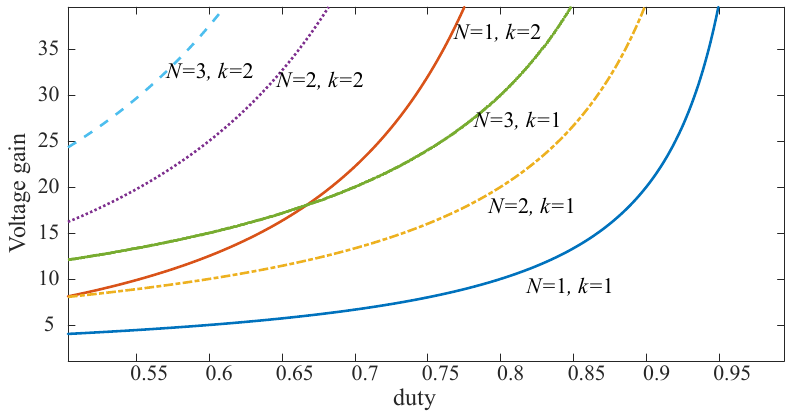
Figure 8. The voltage gain of the proposed converter with different numbers of boost stages k and voltage multiplier cells N